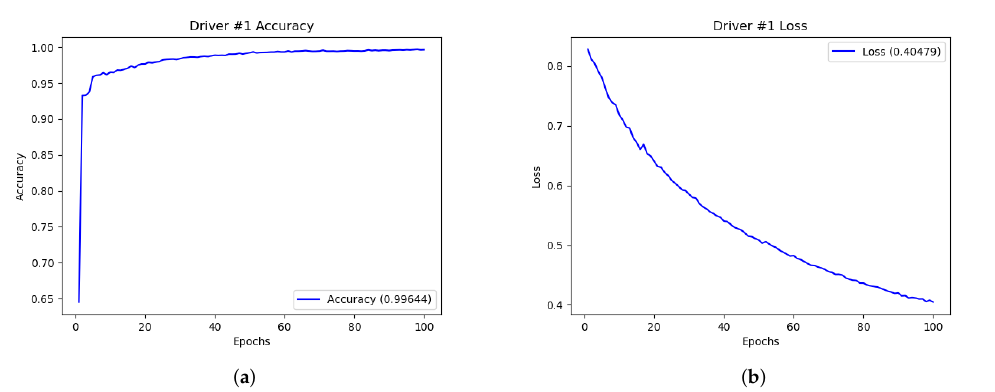
Figure 9. Driver detection performances for Driver #1. In the plot ( a ) the accuracy, in the plot ( b ) the loss.